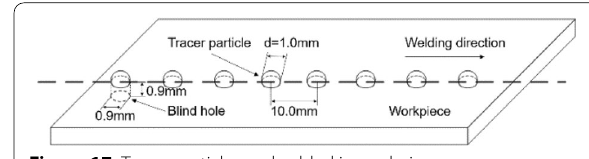
Figure 17 Tracer particles embedded in workpiece